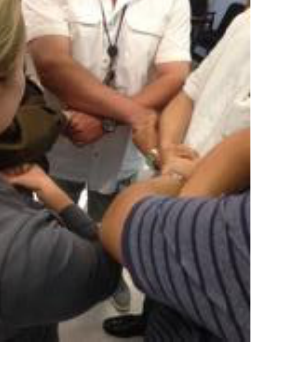
Figure 15 : ‘Unity’ body sculpture